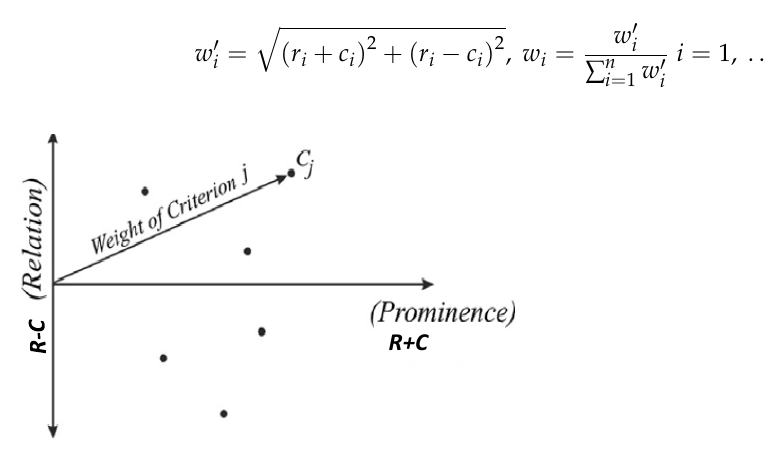
Figure 3. Weight of criterion C j (adapted from [5]). After normalization in (7), the weights w i ( i = 1, . . . , n ) can be used for